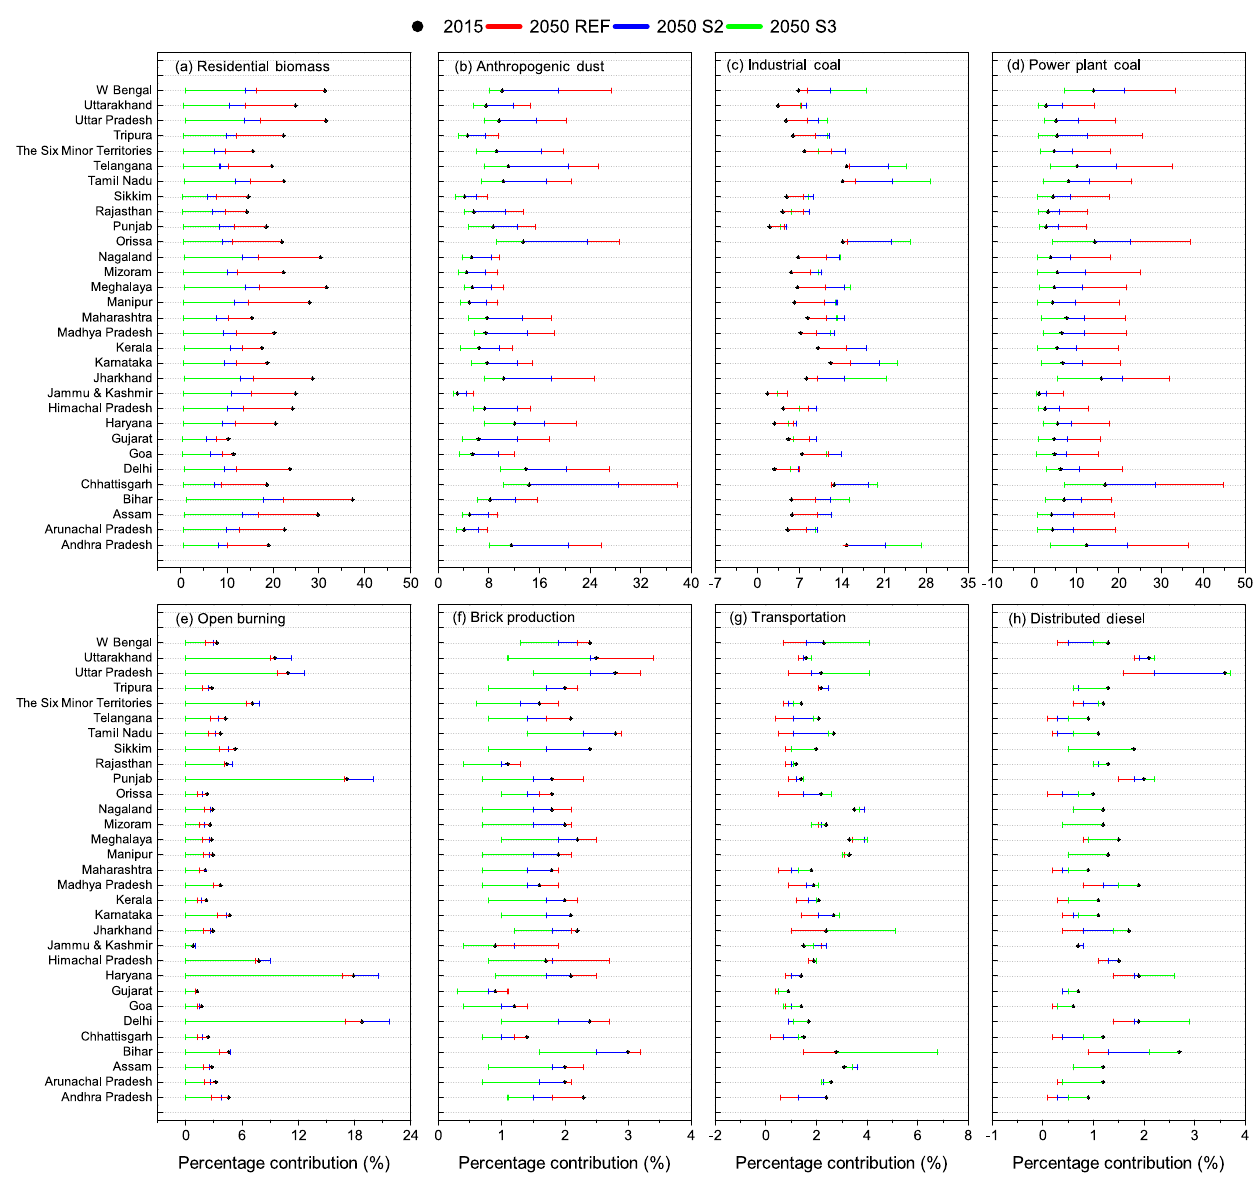
Figure 9. Percentage contribution of (a) residential biomass, (b) anthropogenic dust, (c) industrial coal, (d) power plant coal, (e) open burning, (f) brick production, (g) transportation and (h) distributed diesel attributable to ambient PM 2 . 5 concentration by state